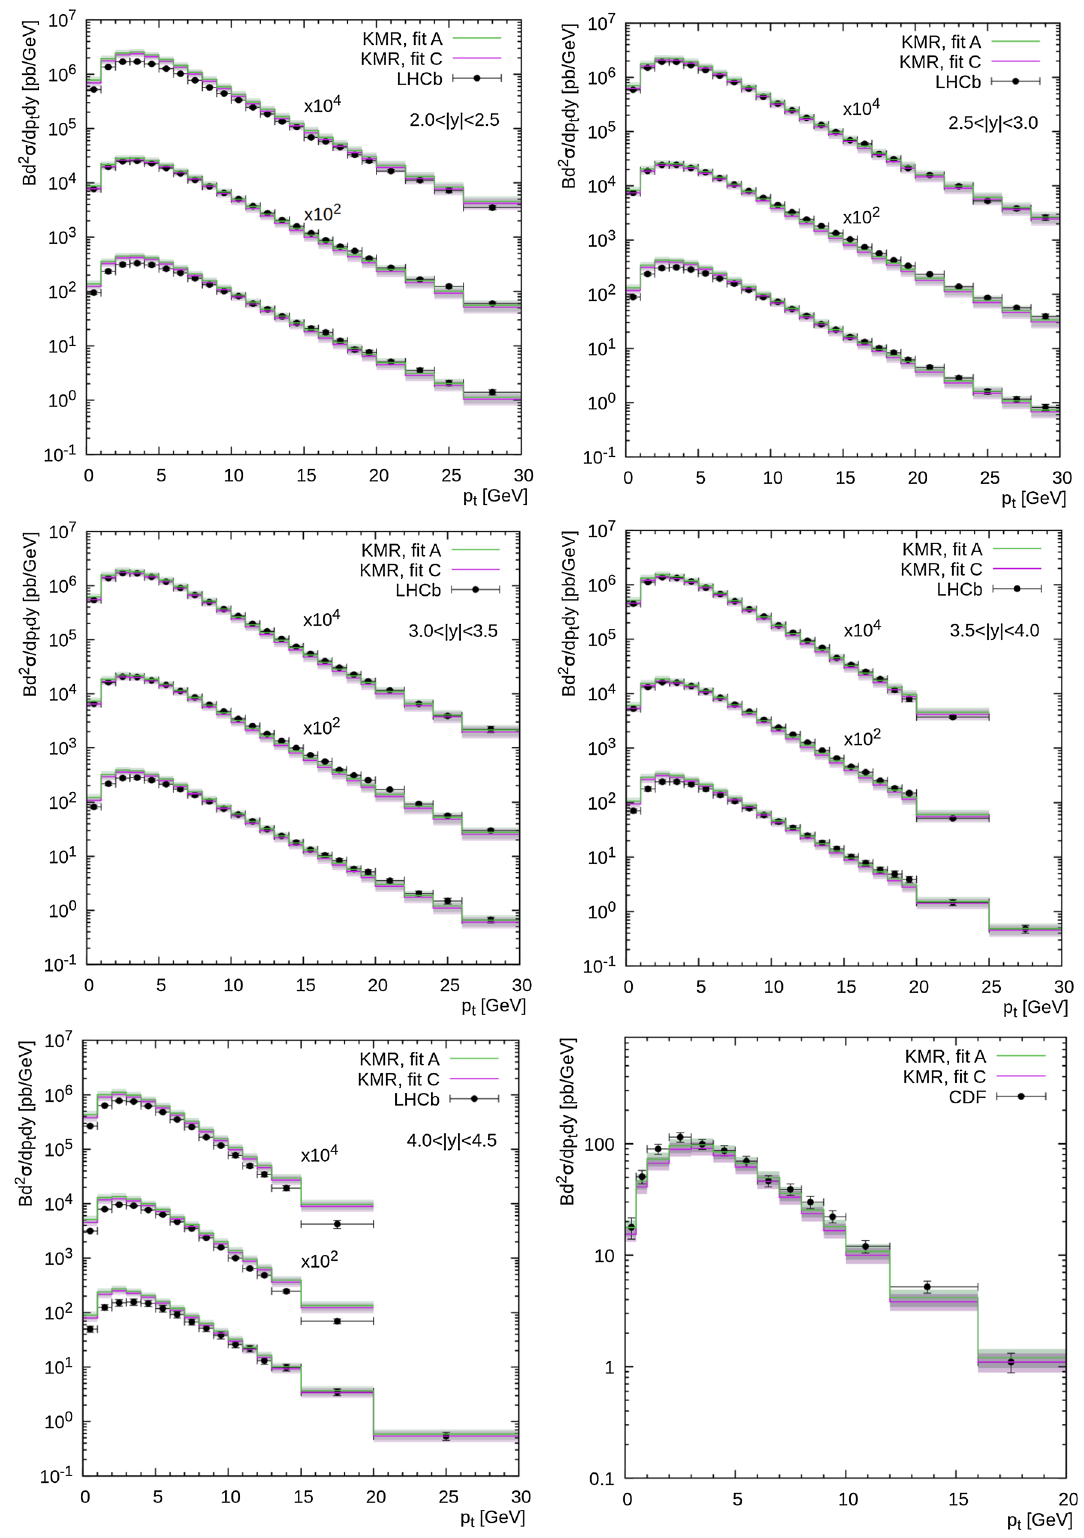
√ s = 1 . 8, 7, 8 and 13 TeV in the different rapidity